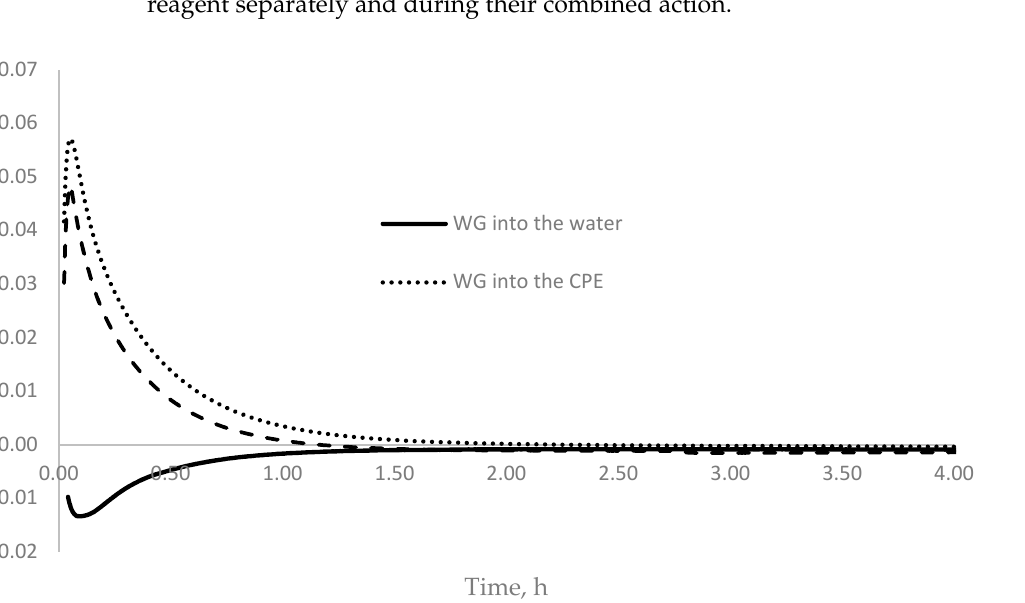
Figure 6. Time dependence of heat release when sodium WG was exposed to various reagents included in cement hydration products.